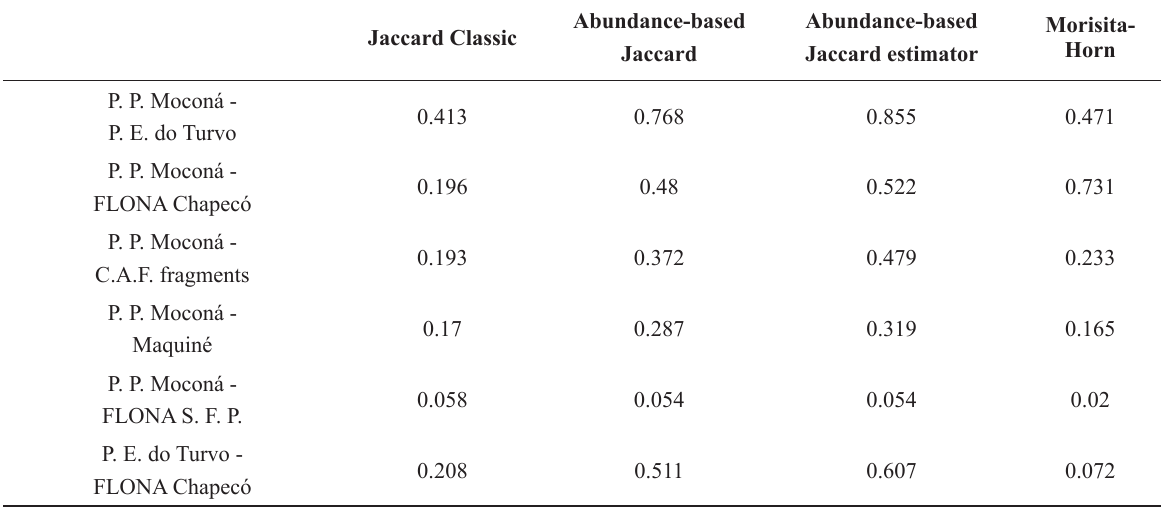
Similarity indices based on presence/absence and abundance data of pentatomids as a measure of beta diversity among six sites of the Atlantic